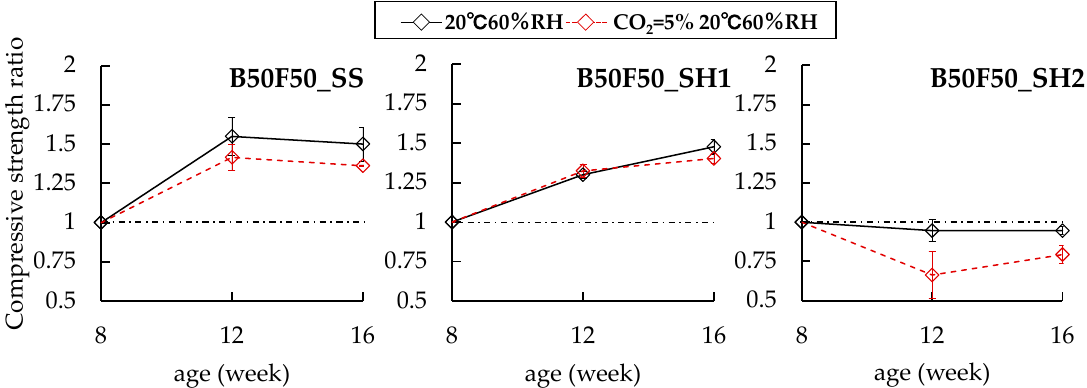
Figure 3. Changes in compressive strength ratios of B100 specimens at 8 weeks.